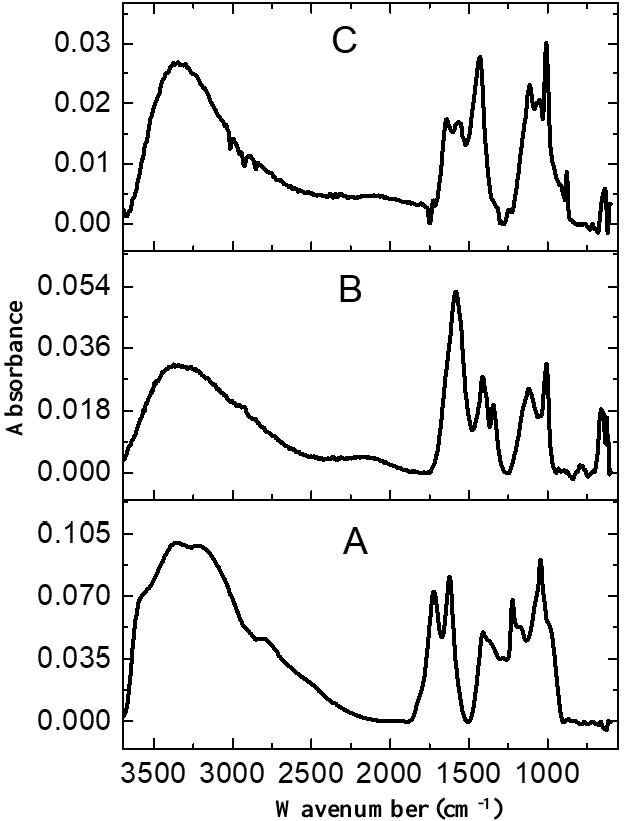
Figure 4. FTIR spectra of rGO ( A ), rGO-ZnS ( B ), rGO-ZnS-Ag ( C ).